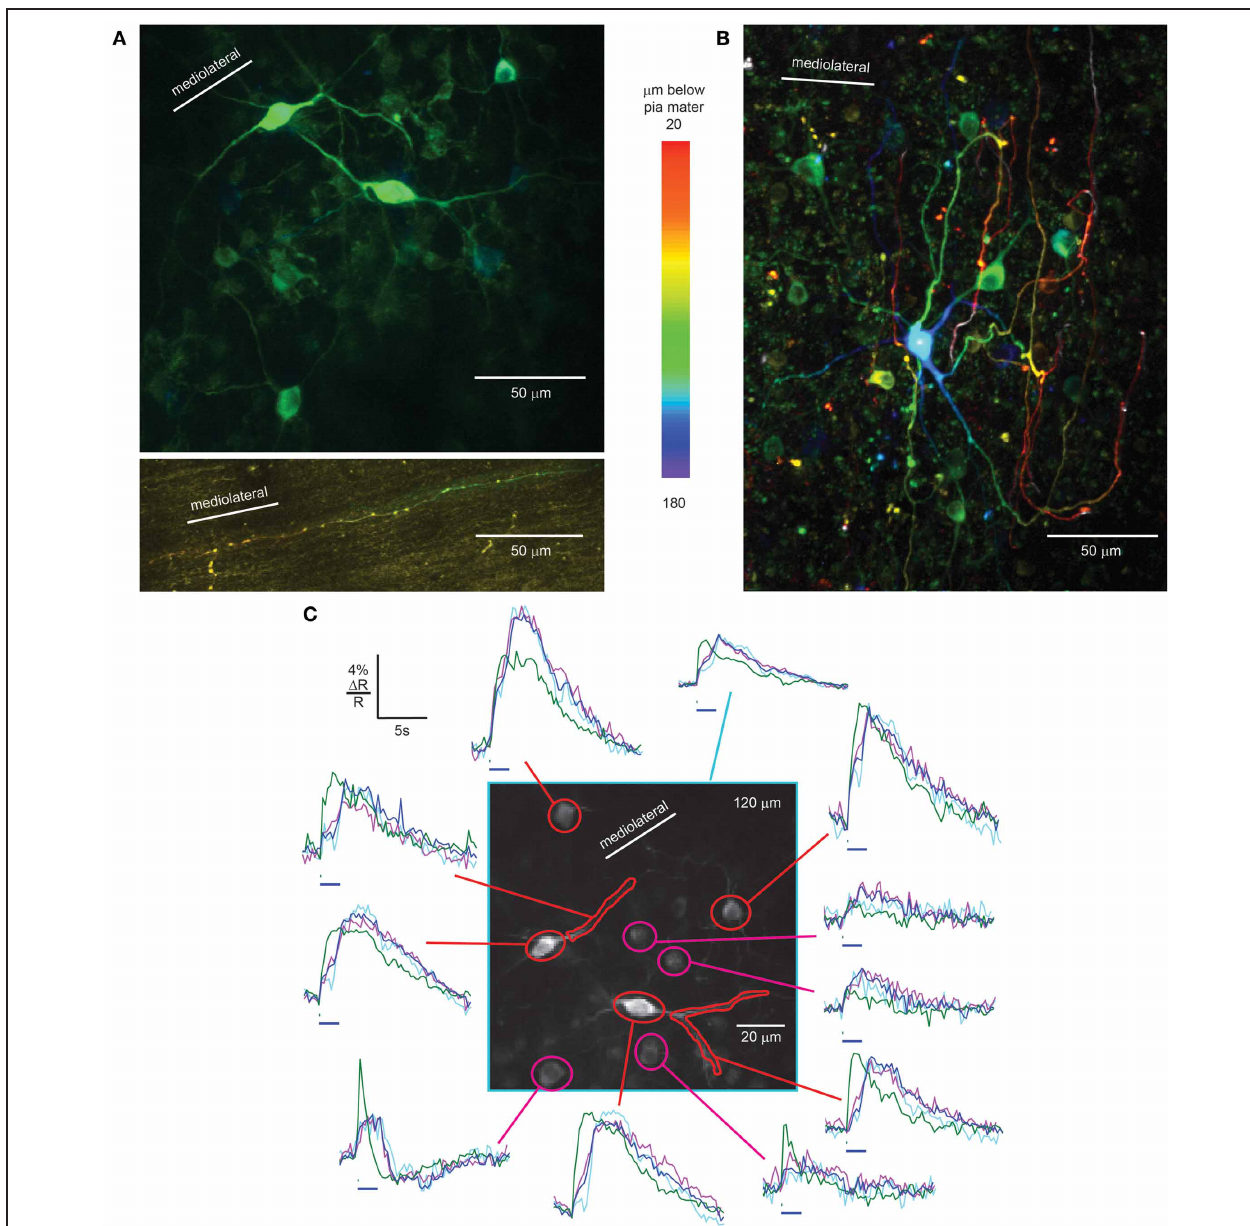
Lugaro cell somata and dendrites (red) and Golgi cells (magenta) in response to 100ms (green trace) and 2-s airpuffs (blue trace), 40 averages. Taking behavior during the 2-s airpuff into account, the purple trace shows the average calcium transient with constant body movement and whisking (20 averages) while the violet trace shows the calcium transient where body movement stopped during the airpuff (17 averages). Horizontal bars, 100-ms, and 2-s airpuff. Number in the upper right corner indicates imaging depth.